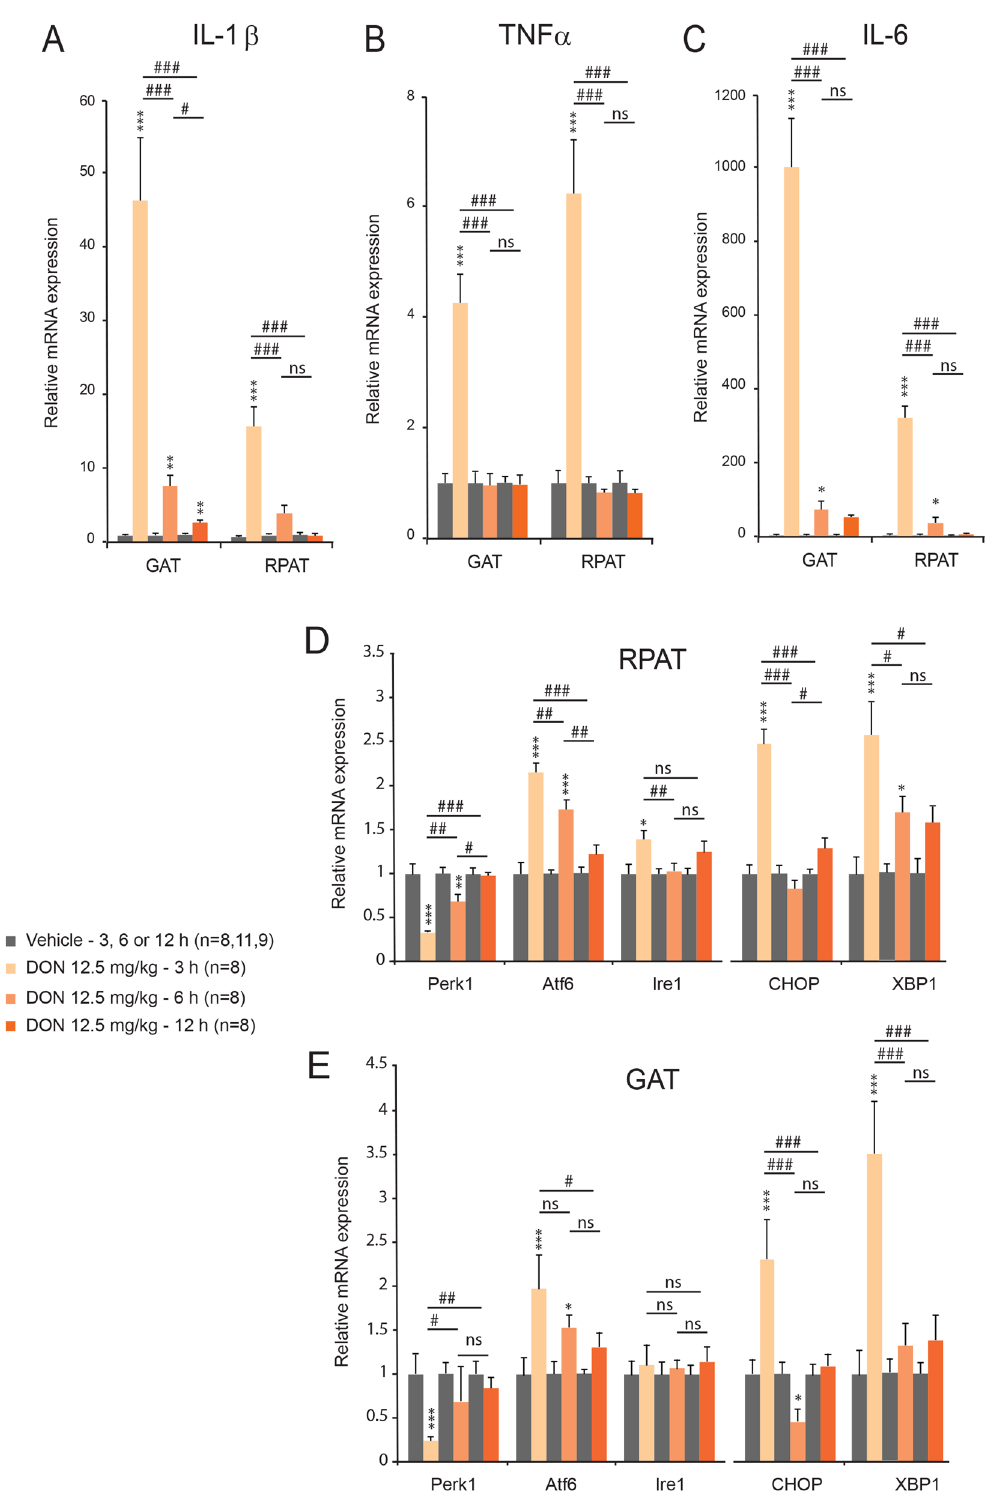
Figure 9. The expression of IL-1α, TNF-β ( B ) and IL-6 ( C ) mRNA and ER stress related genes ( D , E ) was measured by qRT-PCR from RPAT and GAT of control and DON-challenged animals for the indicated times. A two-way analysis of variance test was performed between time series (3, 6 and 12 h) of DON-treated and untreated mice. * P < 0.05, ** P < 0.01 and *** P < 0.001 significantly different from control mice. # P < 0.05, ## P < 0.01 and ### P < 0.001 significant difference between time point of DON-treated mice. ns: no significant